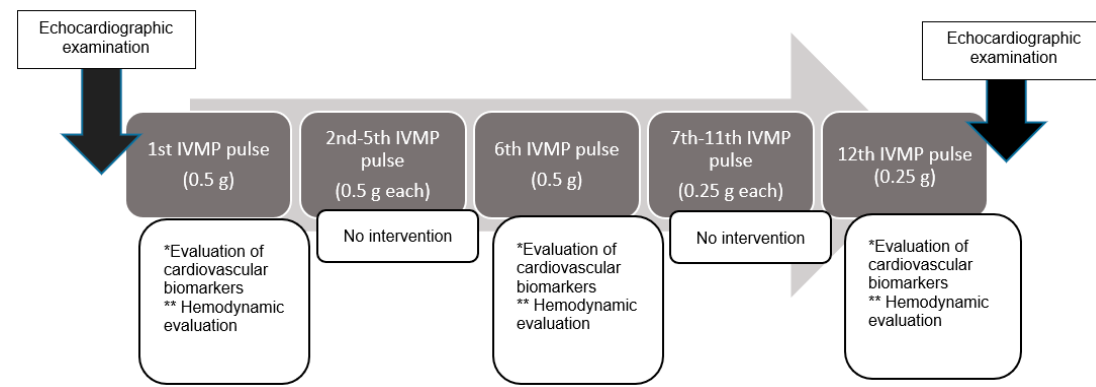
Figure 4. The scheme of study design. * Evaluation of cardiovascular biomarkers included examination of N-terminal pro-brain natriuretic peptide, troponin I, 24 and 48 h after intravenous methylprednisolone (IVMP) pulse. ** Hemodynamic evaluation included 48-h ambulatory blood pressure monitoring during 24-h before and 24-h after IVMP infusion.